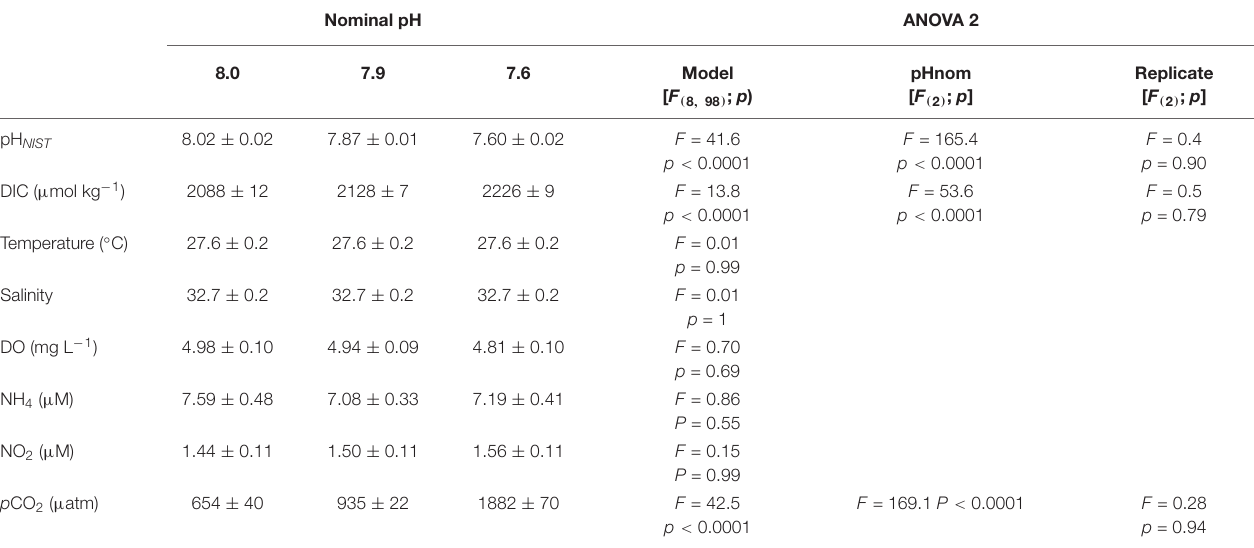
TABLE 1 | Physico-chemical parameters for each nominal pH treatment and results from respective analyses of variance testing the impact of pH treatment and difference between